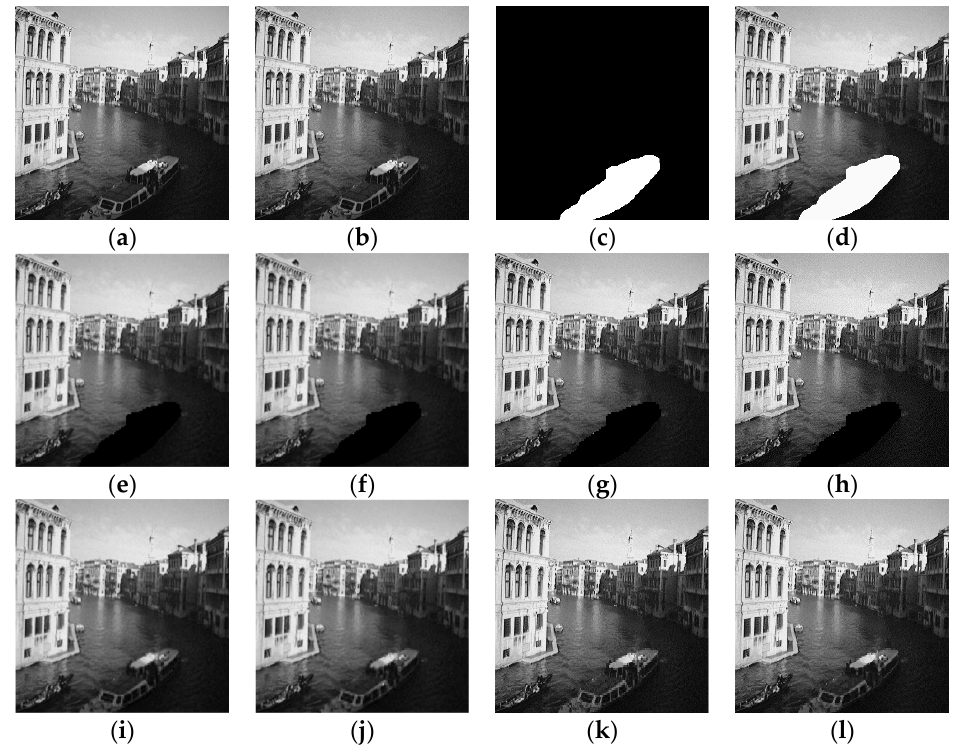
Figure 10. Tamper detection and recovery results of an image deletion attack on the Venice image: ( a ) original image; ( b ) watermarked image; ( c ) tamper reference; ( d ) tampered image; ( e ) tamper detection result of [8]; ( f ) tamper detection result of [9]; ( g ) tamper detection result of [7]; ( h ) tamper detection result of the proposed method; ( i ) recovery result of [8]; ( j ) recovery result of [9]; ( k ) recovery result of [7]; ( l ) recovery result of the proposed method.